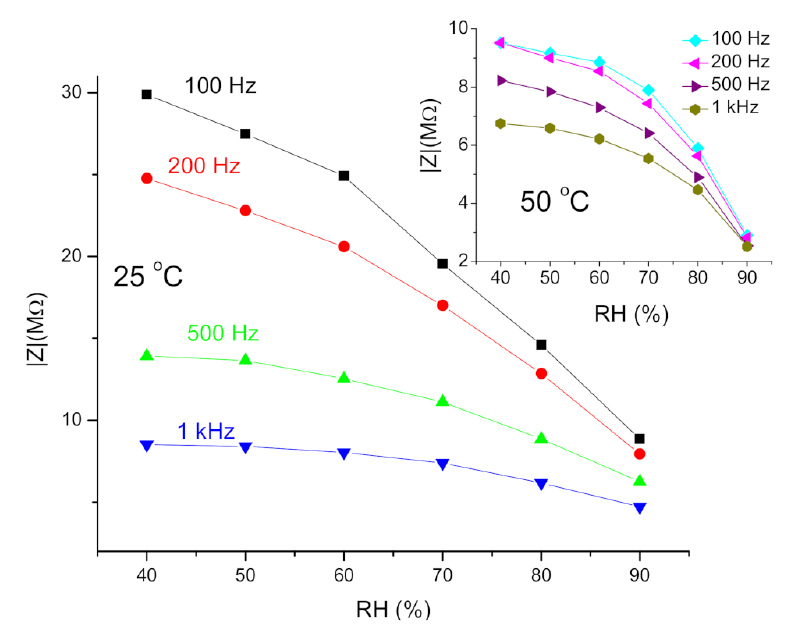
Figure 7. Impedance dependence on RH measured at selected frequencies.